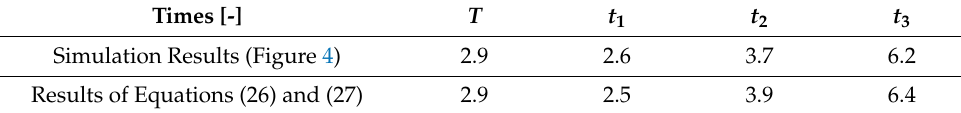
Table 2. Comparison between the simulation and analytical results. Times [-] T Simulation Results (Figure